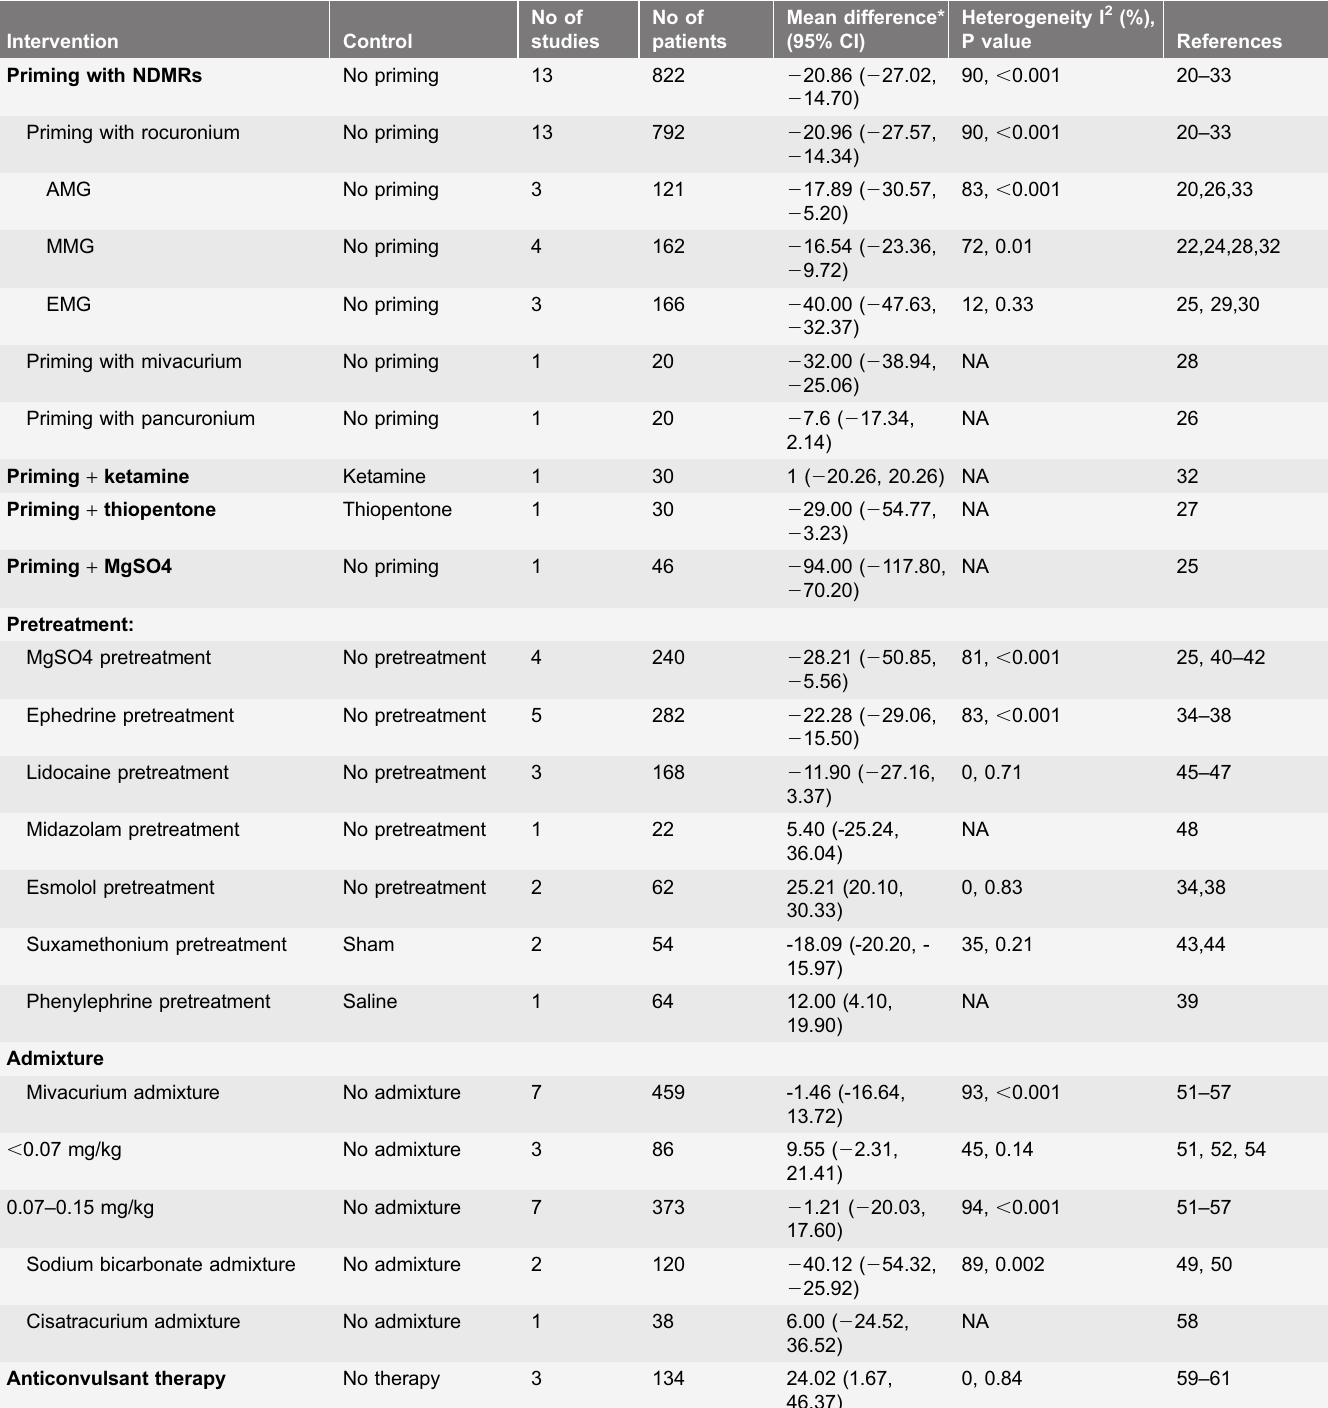
Table 1. Efficacy results of pharmacological interventions in reducing the onset time of rocuronium.